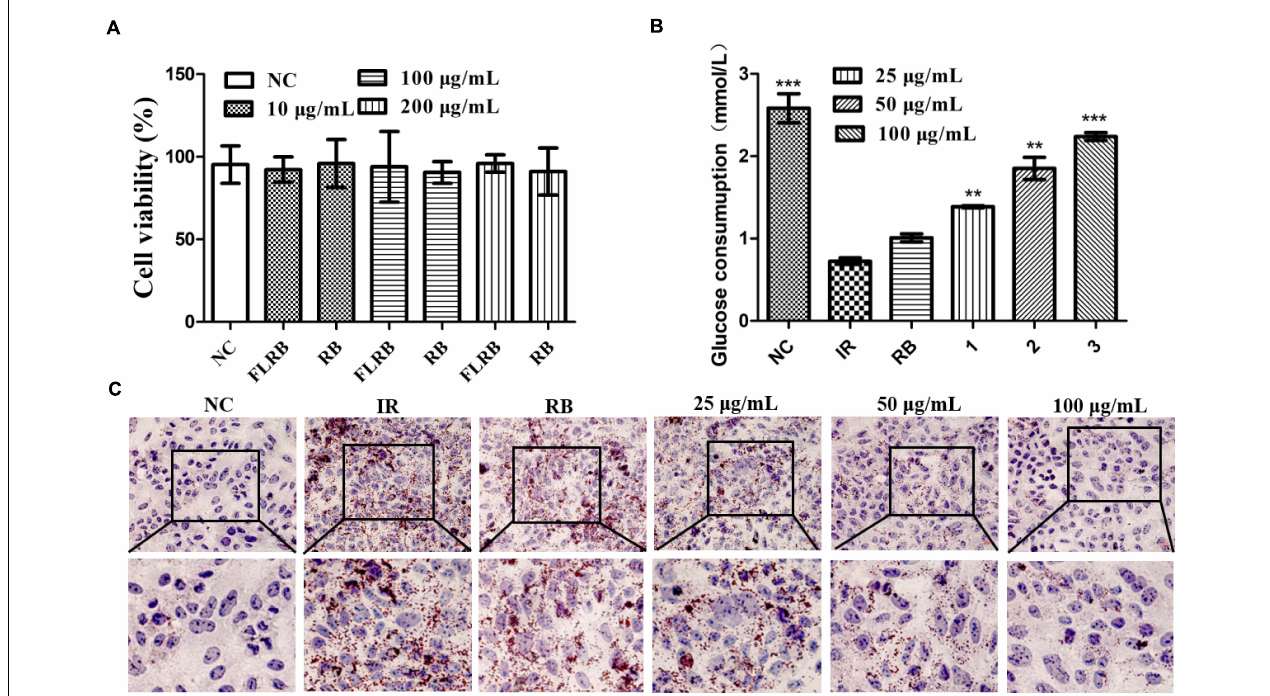
FIGURE 1 | Analysis of the effects of FLRB in vitro . Cells were treated with FLRB and RB at various concentrations. (A) HepG2 cell viability was examined by the 3-(4,5-dimethylthiazol-2-yl)-2,5-diphenyltetrazolium bromide (MTT) assay; (B,C) glucose consumption and lipid accumulation assay of Lactobacillus fermentum MF423-fermented rice bran extracts (FLRB) at 25, 50, and 100 µ g/mL was determined in insulin resistant-HepG2 (IR-HepG2) cells for 24 h; the concentration of unfermented rice bran extracts (RB) used was 100 µ g/mL. Values are expressed as the mean ± SD ( n = 3). *** represents P < 0.001, ** represents P < 0.01, compared to the IR.